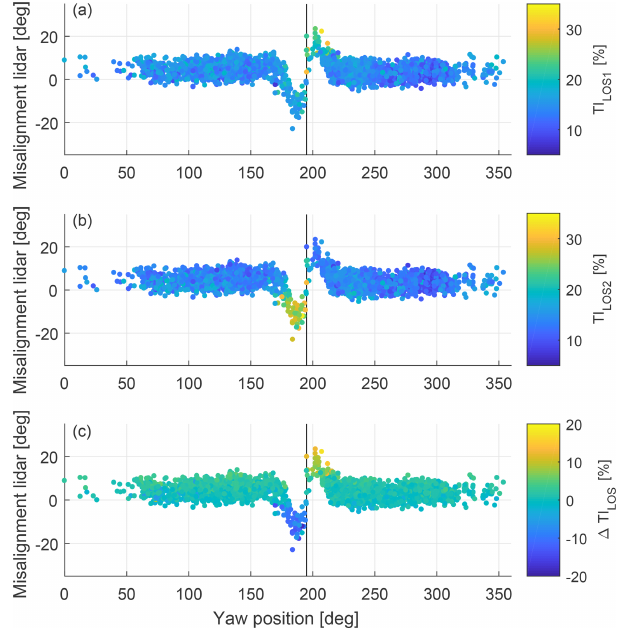
Figure 8. Lidar-estimated 10min mean yaw misalignment b φ as function of turbine yaw position. (a) TI LOS (c) (cid:49) TI LOS . The vertical black line indicates the position of the upstream Nordtank turbine (at 195 ◦